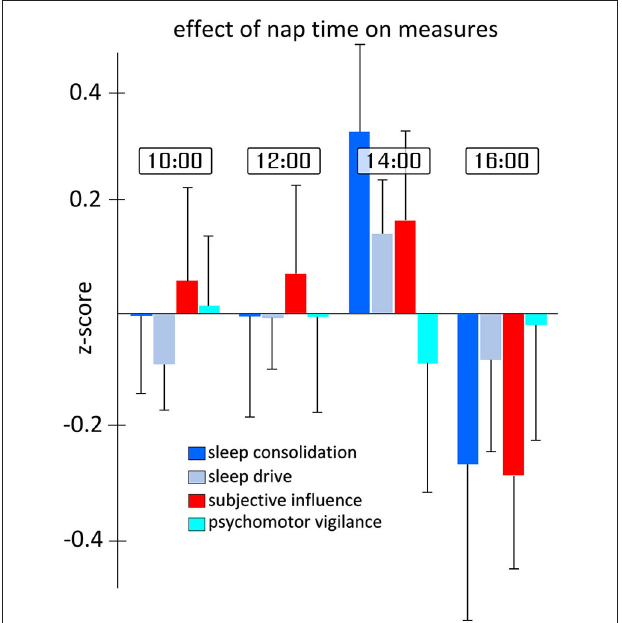
FIGURE 3 | Effect of theta-burst stimulation on the participants’ latency to non-REM stage 2 and total sleep efficiency . Two theta-burst protocols were used, continuous (cTBS), and intermittent (iTBS) over the left dorso-lateral prefrontal cortex or the left associative cortex in different sessions. (A) (Top) shows the participant’s mean latency to sleep stage 2. (B) (Bottom) shows the mean total sleep efficiency, measured as the percentage of total time asleep in any sleep stage over the total time spent in bed. Error bars indicate the standard error for each measurement. See